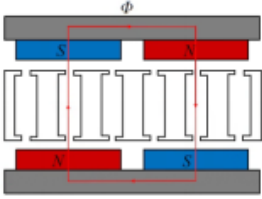
Figure 1. The main magnetic flux of the YASA machines.